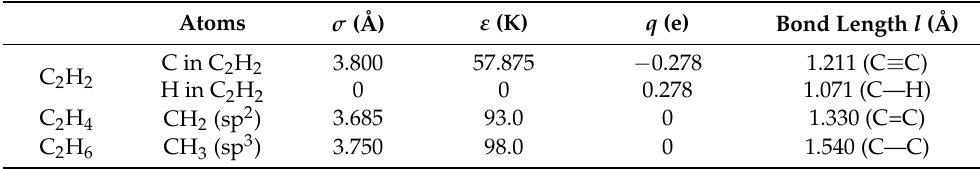
Table 1. Molecular Parameters of C 2 H 2 , C 2 H 4 , and C 2 H 6 . Atoms σ (Å) ε (K) Bond Length l